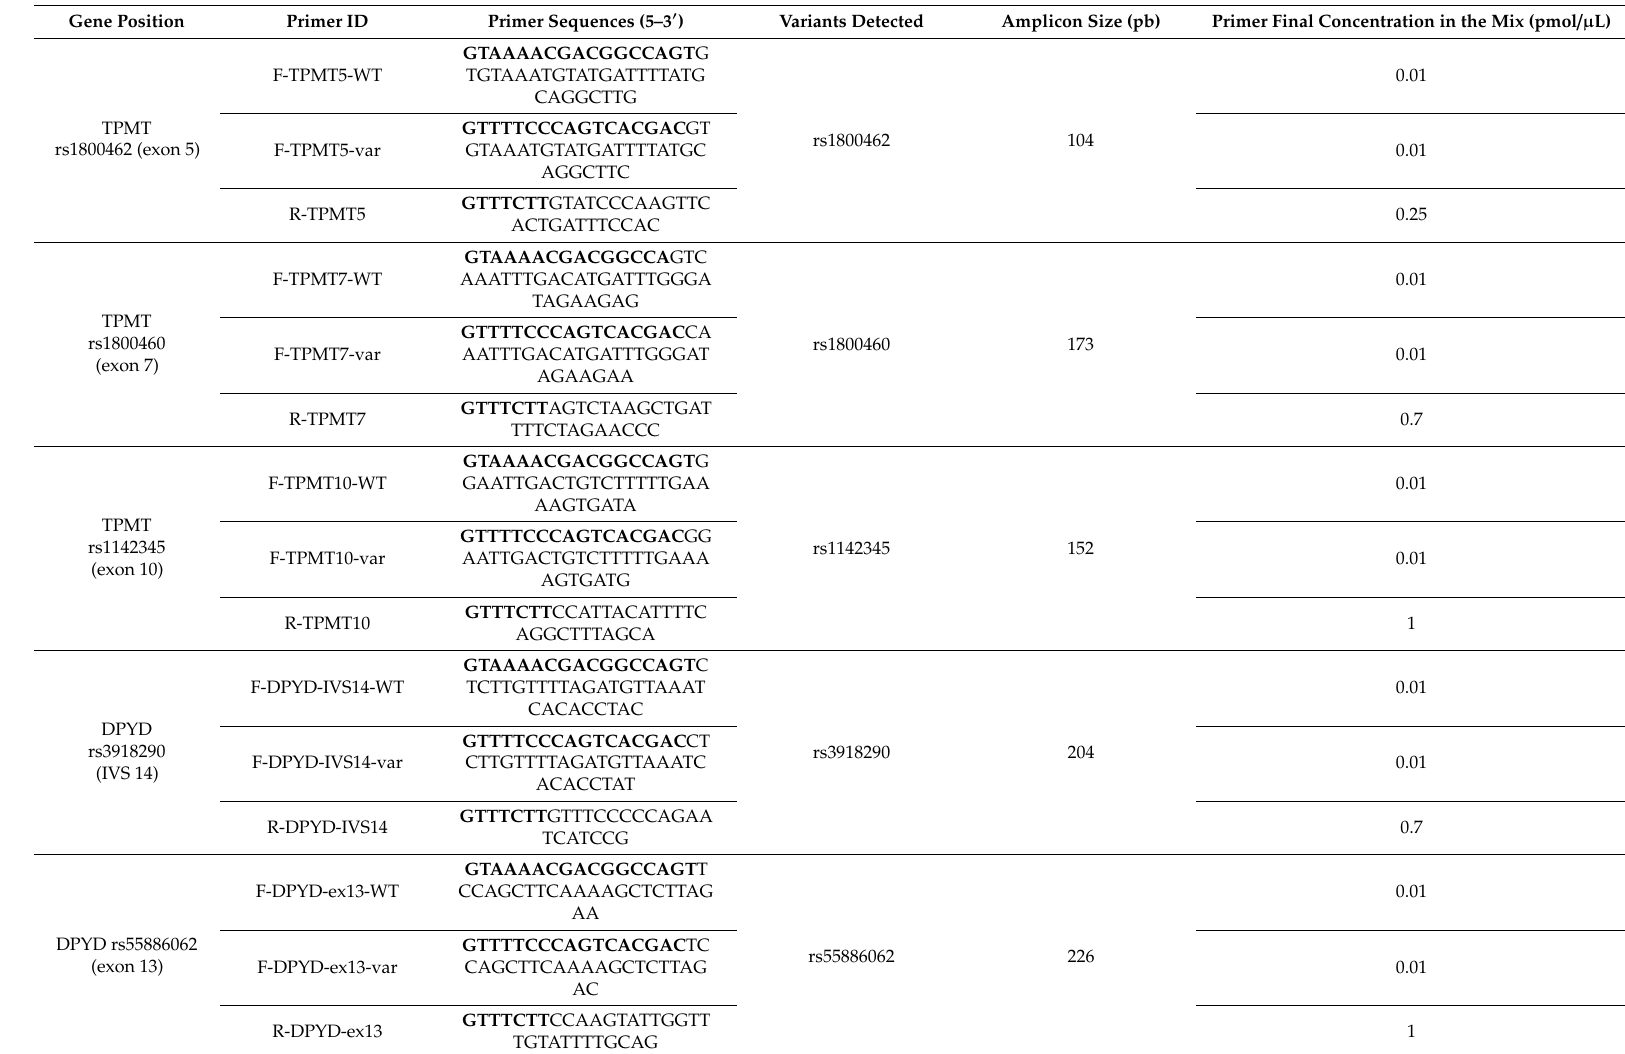
Table 5. Design of primers used in the